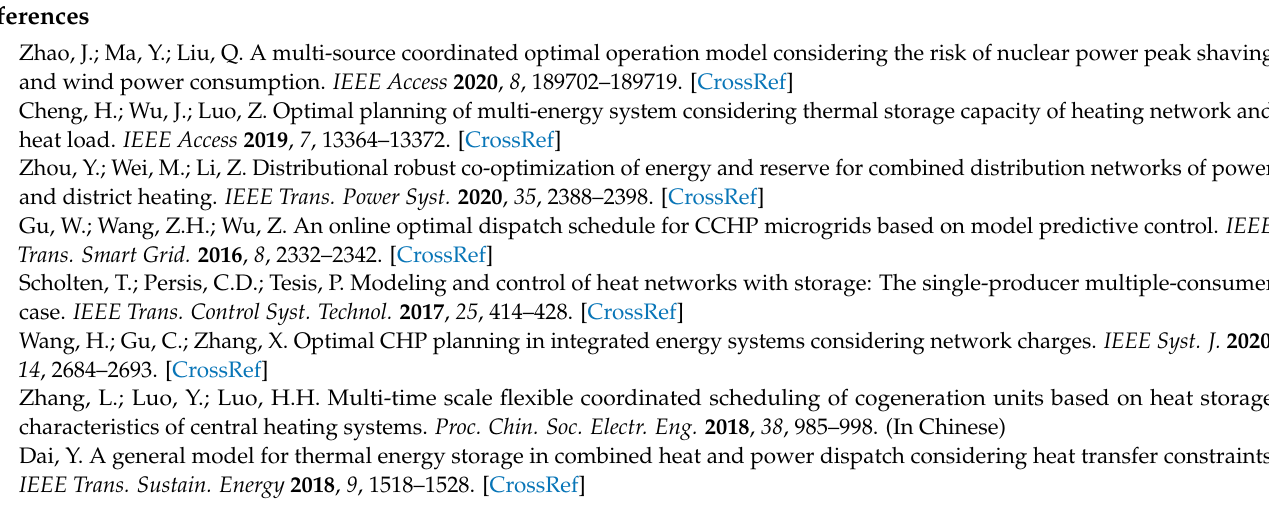
Table 12 establishes that the scheduling results solved by the improved algorithm are obviously